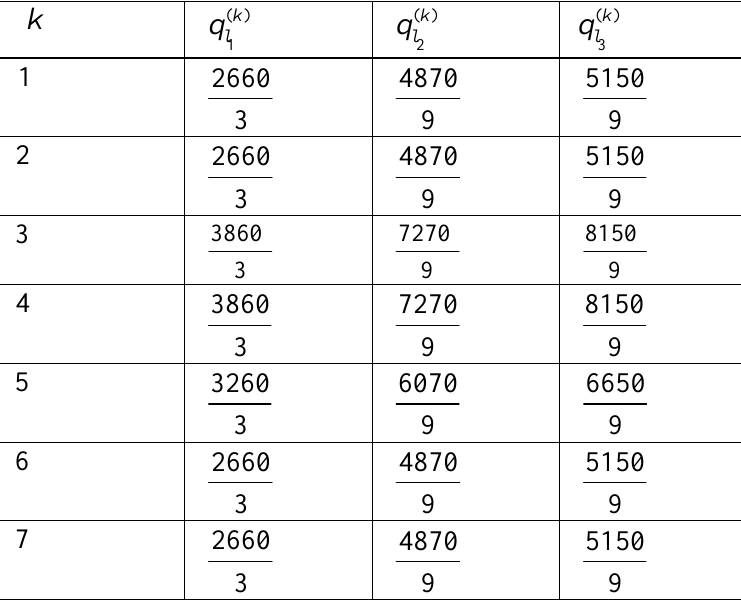
Table 1. The optimal link traffic flows [veh/h] and link travel times [h]-total travel time